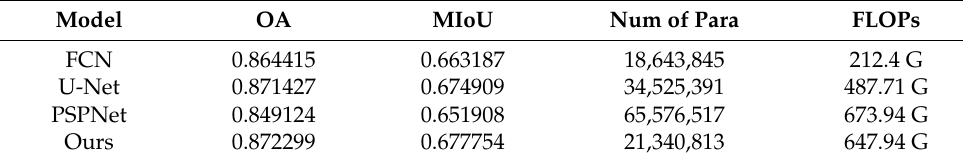
Table 3. Different model performance.